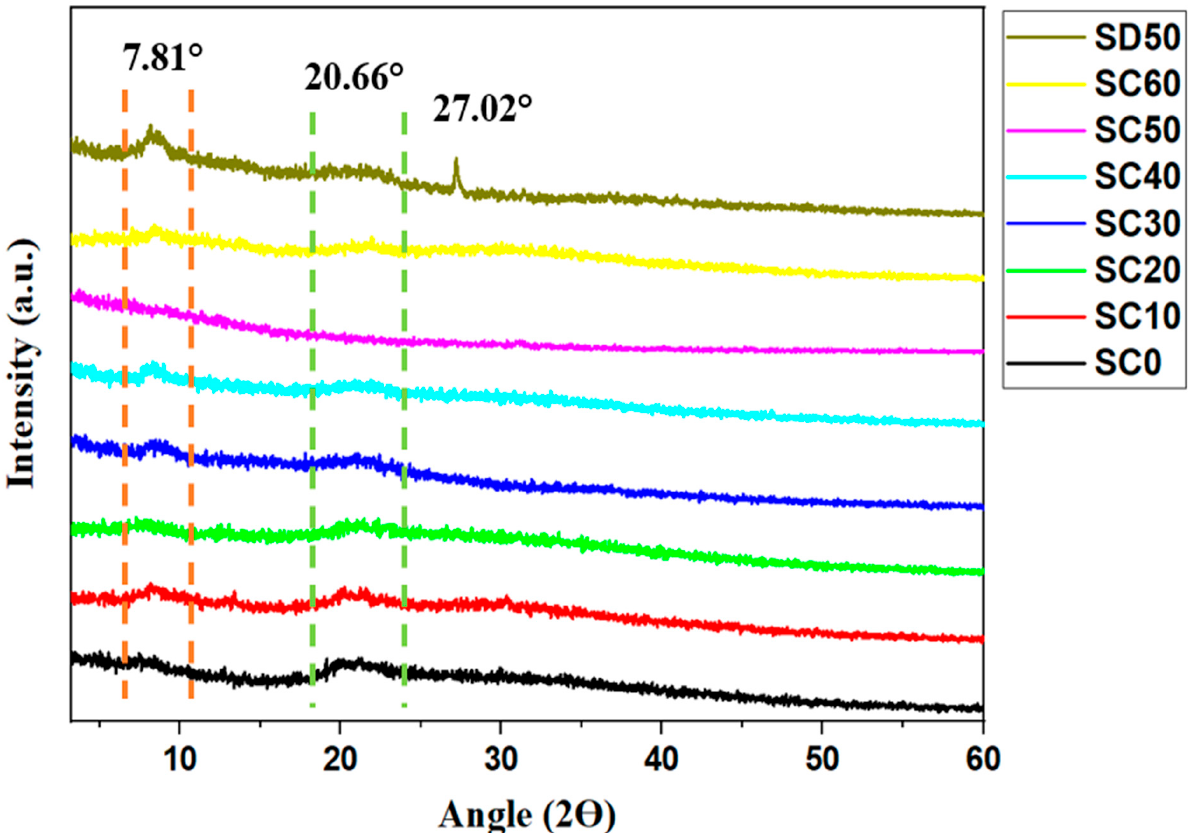
Figure 2. XRD pa tt erns of unplasticized and glycerol-plasticized MC/PC/K 3 PO 4 SBEs. Figure 2. XRD patterns of unplasticized and glycerol-plasticized MC/PC/K